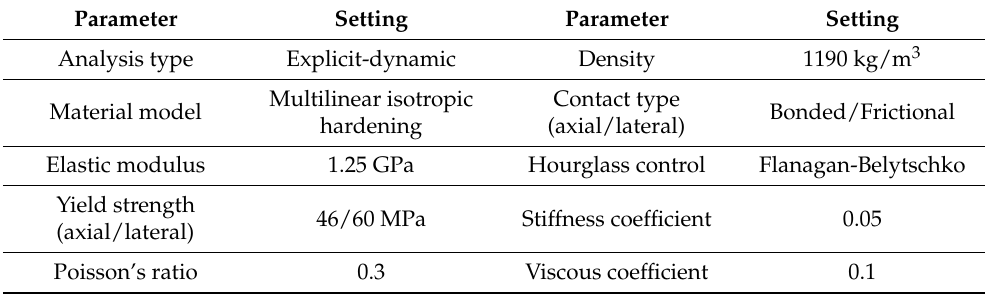
Table 2. FE analysis